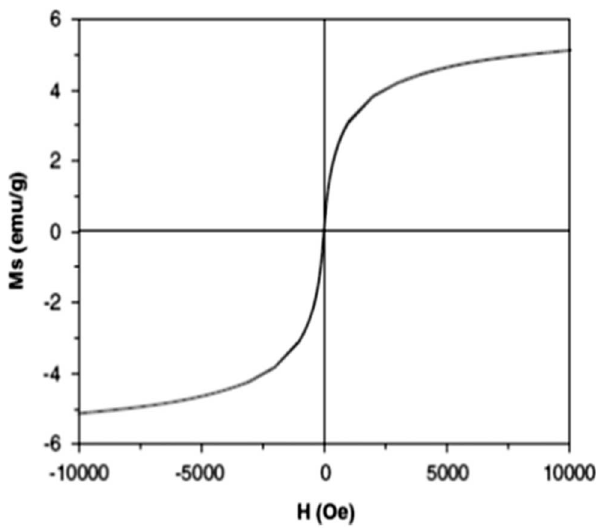
Figure 2. Hysteresis loop obtained from VSM measurements of synthesized MNPs capped with ascorbic acid at 300 K. It shows the magnetization (Ms) in an electromagnetic unit per gram (emu/g) in response to the magnetic field (H) in Oersted (Oe). MNPs saturation magnetization is 5.2 emu/g.